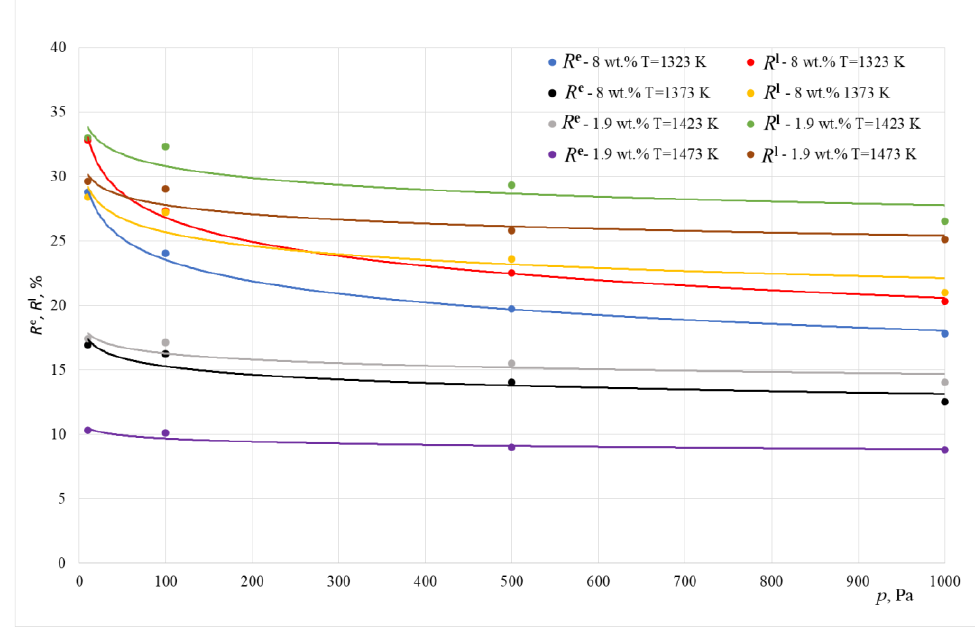
Figure 6. The share of the R e and R l resistance in the overall resistance of the evaporation process (ICF).